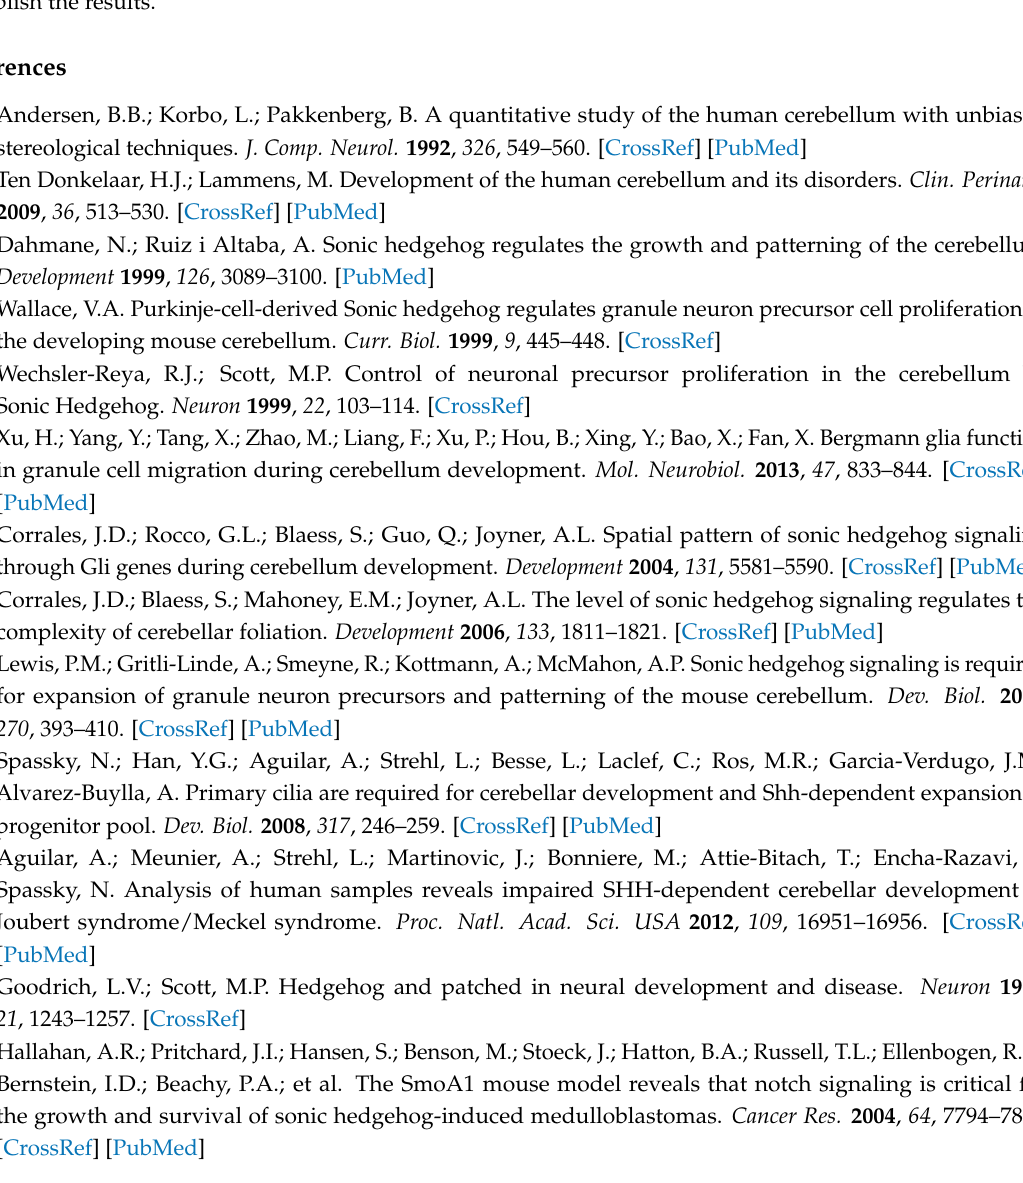
Figure S1: GFAP-Cre recombination occurs in the Bergmann glia of the cerebellum, Figure S2: Pcp2-Cre recombination occurs in the Purkinje cells of the